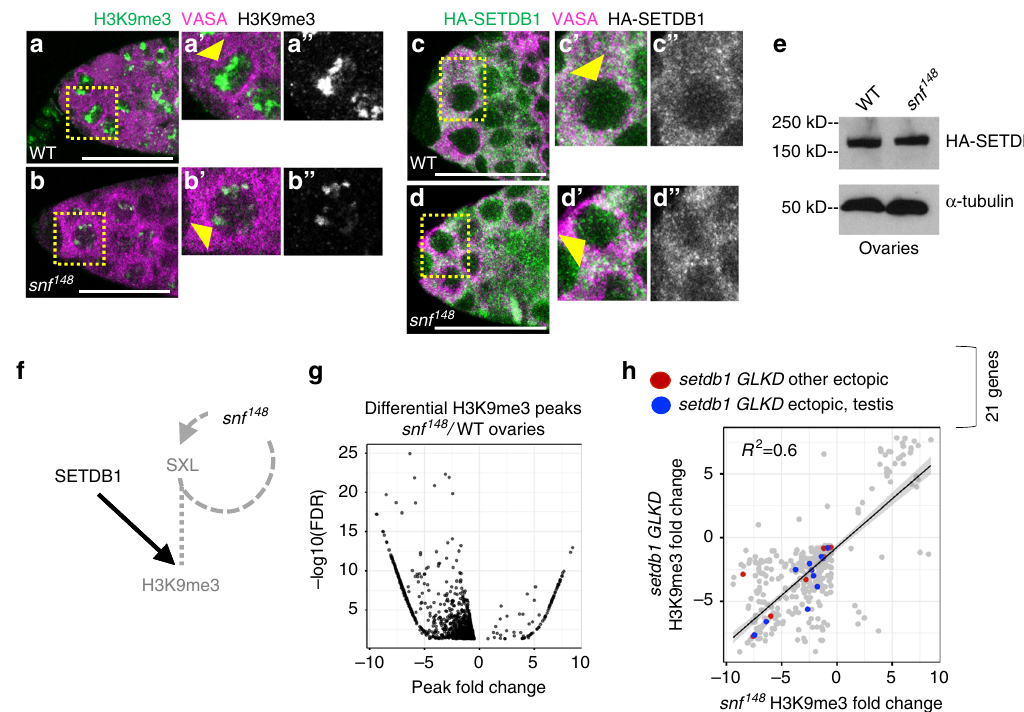
Fig. 6 H3K9me3 distribution is affected in snf 148 mutant ovaries. a , b Reduced H3K9me3 staining in snf 148 mutant germ cells. Confocal images of a